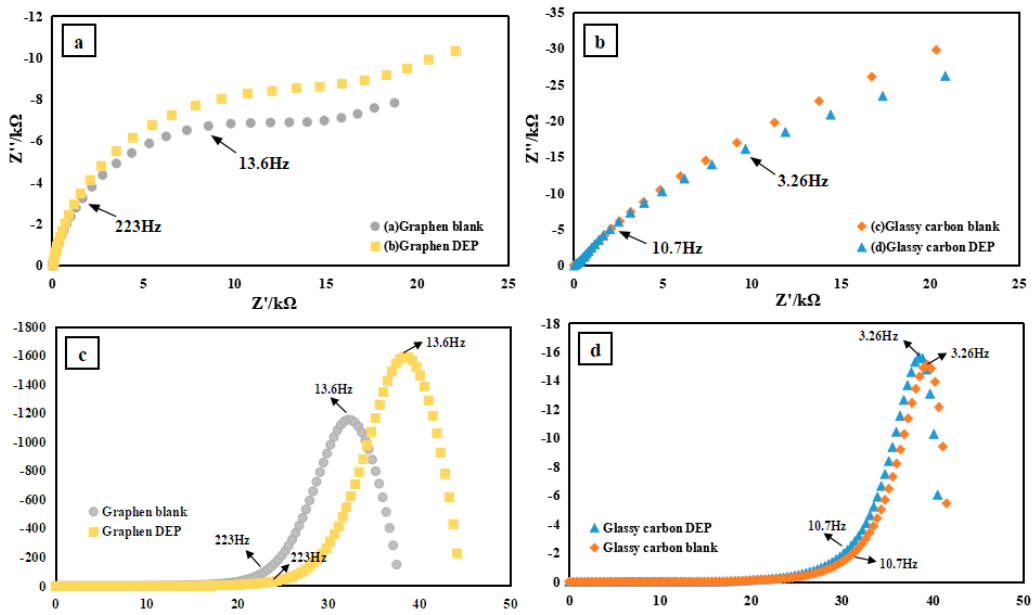
Figure 10. ( a , b ) Comparison of EIS responses of glassy carbon electrode and graphene electrode; ( c , d ) display after deconvolution processing, respectively, (reprinted from Ref. [38]).